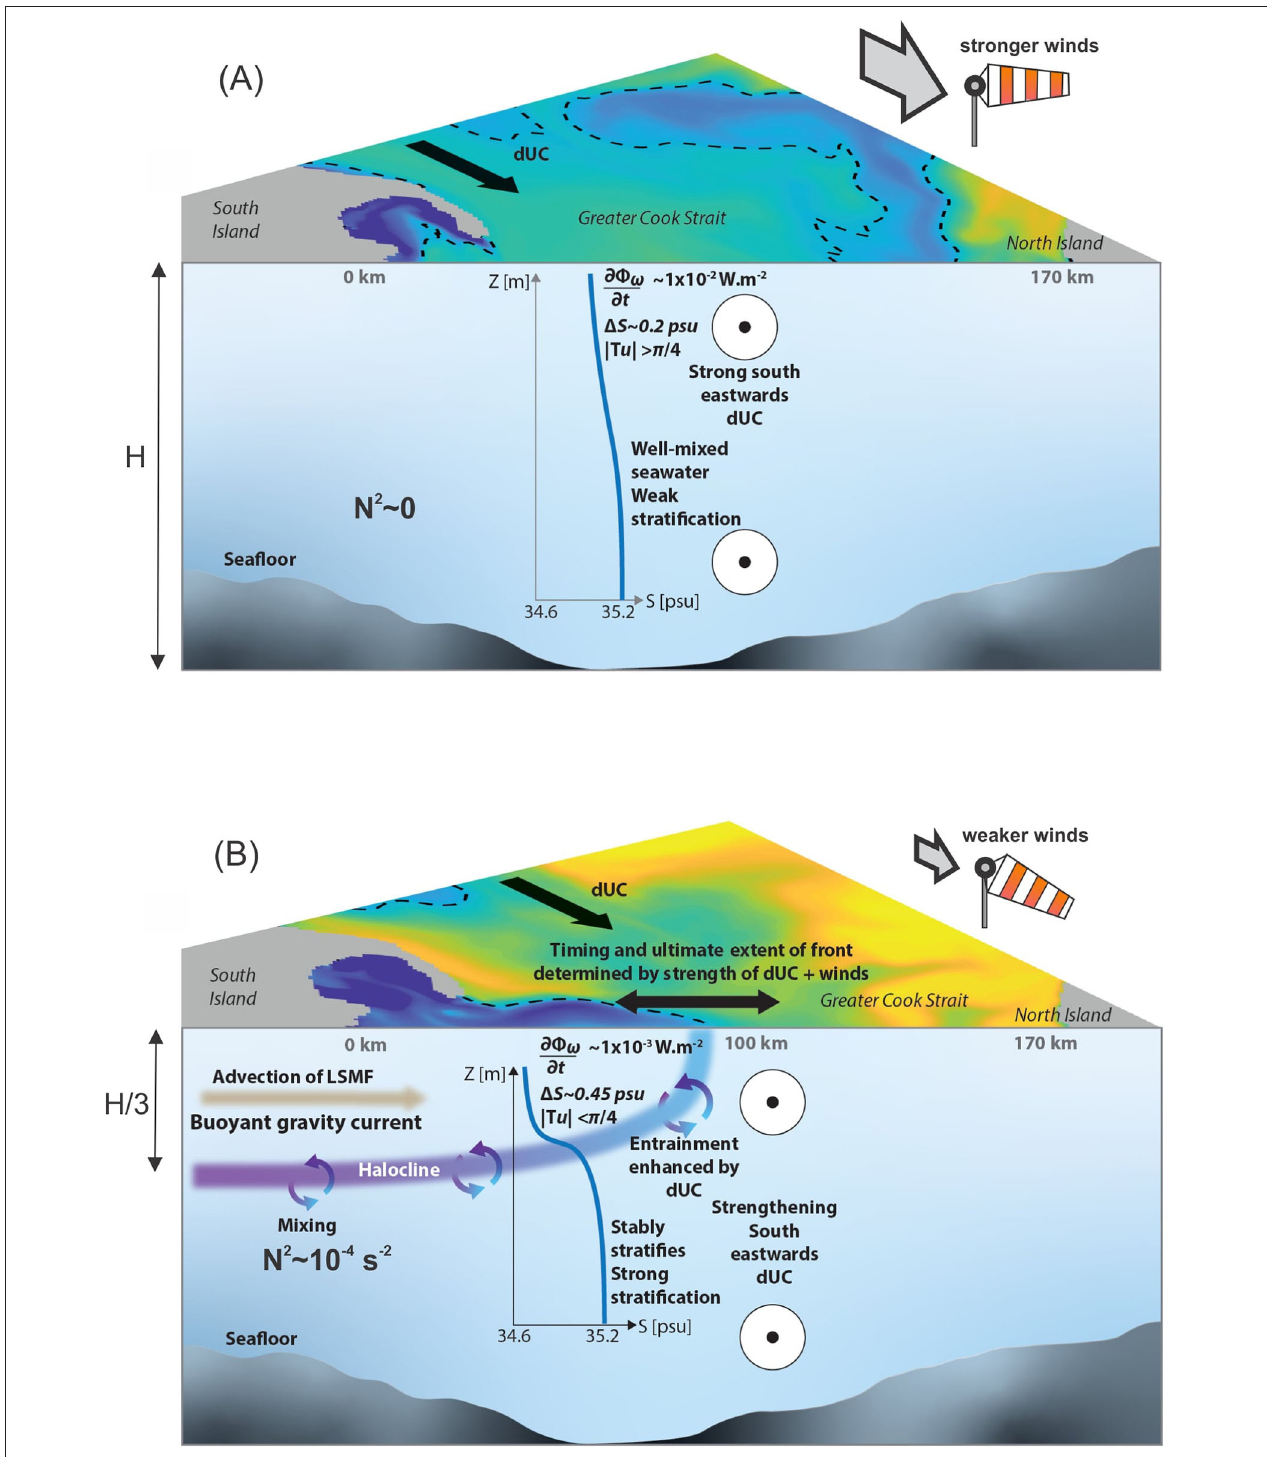
FIGURE 11 | Schematic of Greater Cook Strait (A) in the absence of an LSMF indicating typical salinity profile, wind mixing power, and Tu in the presence of a strong wind-driven d’Urville Current and (B) in the presence of an LSMF propagating offshore, indicating typical salinity profile, wind mixing power, and Tu as it undergoes entrainment when it interacts the wind-driven d’Urville